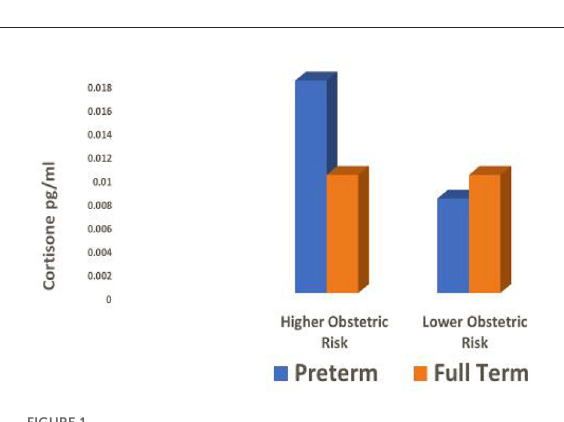
FIGURE1 Hair cortisone levels during pregnancy by obstetric risk and birth